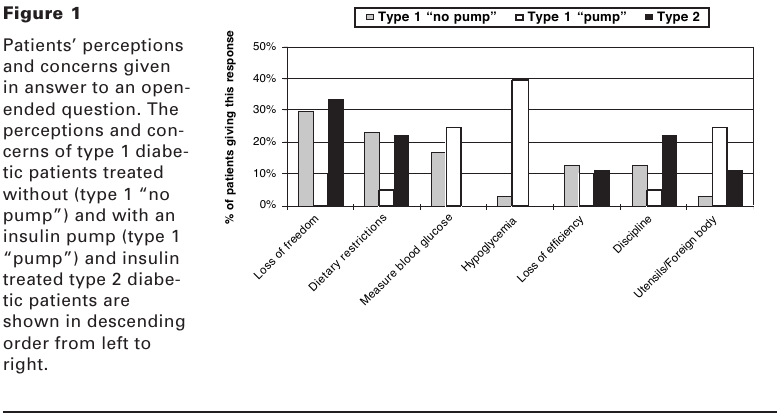
Demographics of study